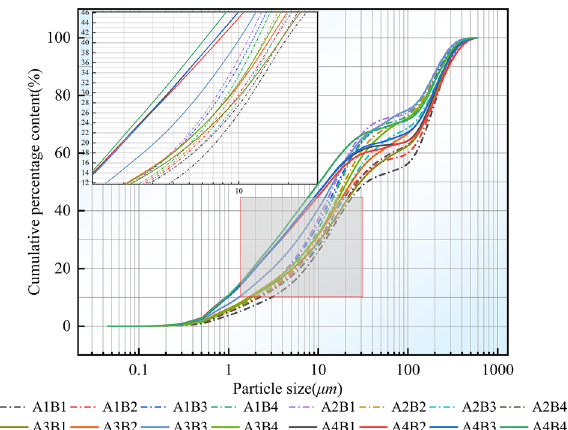
Figure 3. The plot of the cumulative frequency distribution curve.